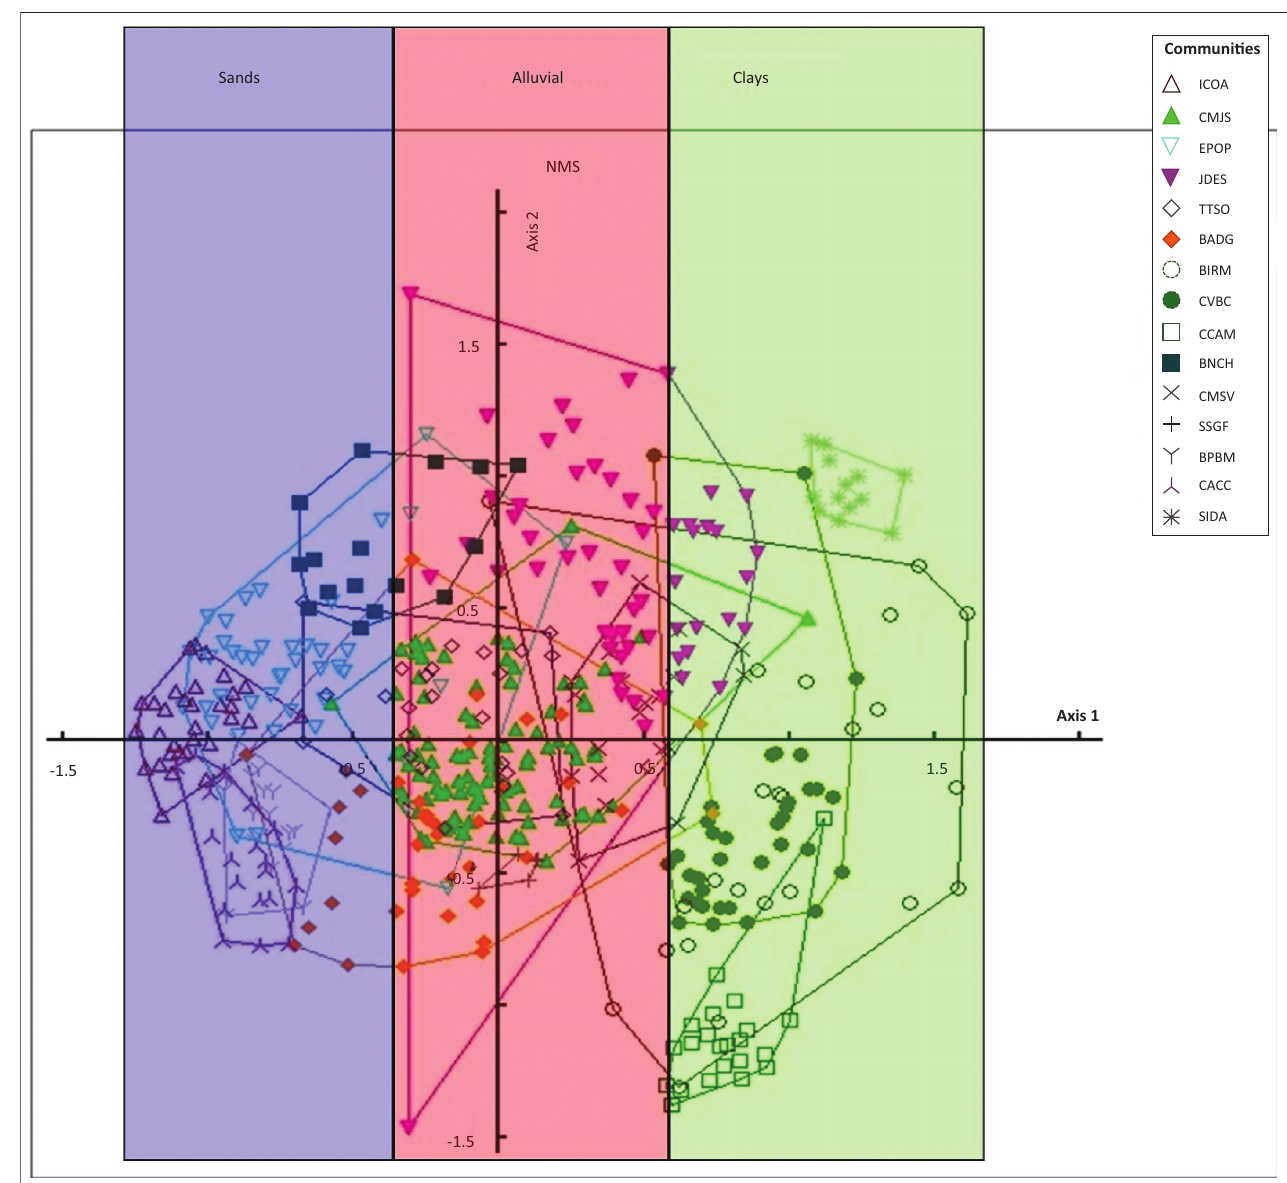
FIGURE 3: Non-metric multidimensional scaling ordination of plant communities on 801